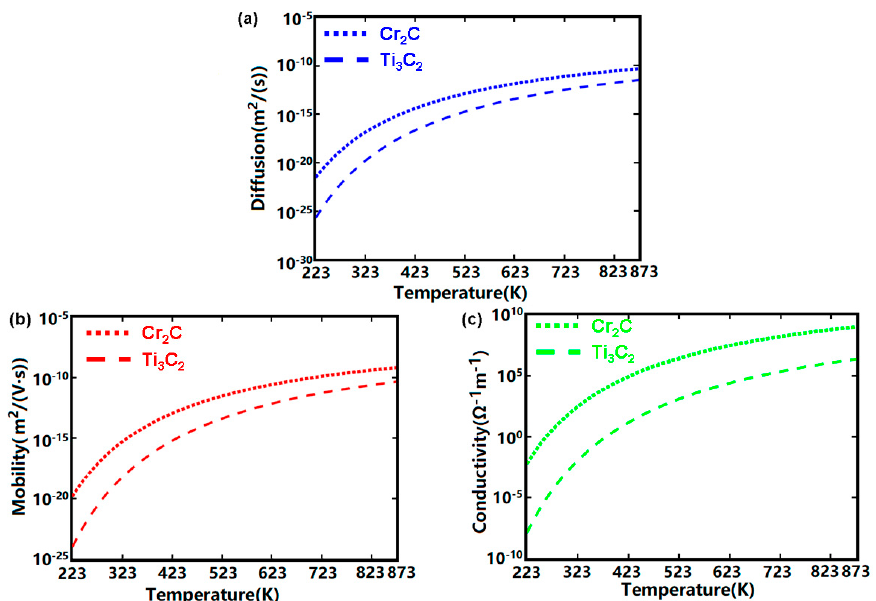
Figure 4. Electrical conduction coefficients of Cu atoms diffusing through Cu/Cr2C/TiN including ( a ) di ff usivity, ( b ) mobility, and ( c ) electrical conductivity with respect to temperature.